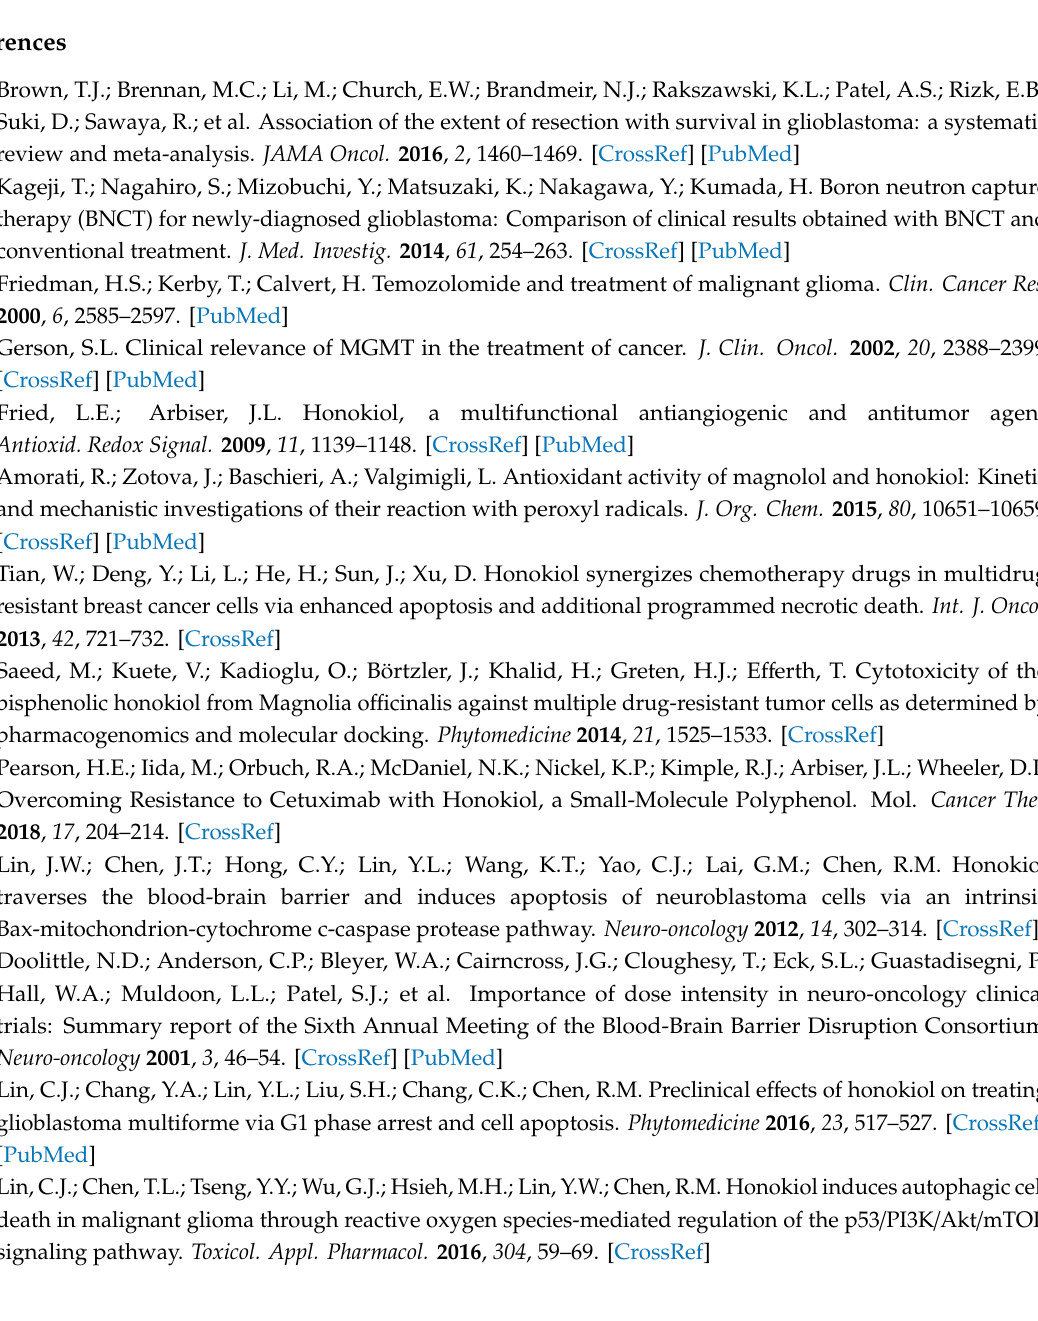
Figure S1. E ff ects of honokiol on proliferation and viability of human malignant drug-resistant glioblastoma